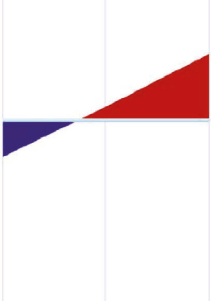
Figure 18: Normal stress distribution at y � − 10.562m at final excavation level.